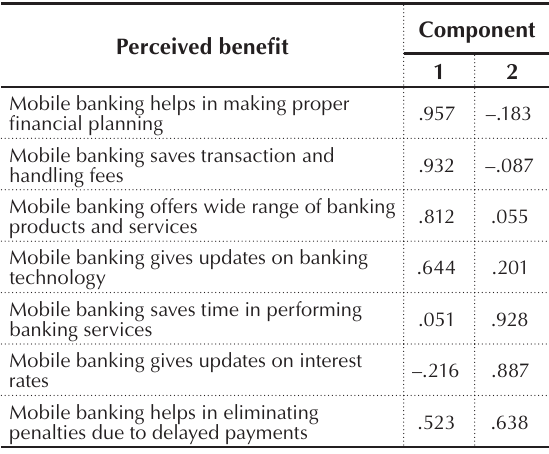
Table 4. (cid:38)(cid:258)(cid:272)(cid:410)(cid:381)(cid:396)(cid:3)(cid:258)(cid:374)(cid:258)(cid:367)(cid:455)(cid:400)(cid:349)(cid:400)(cid:3)(cid:381)(cid:374)(cid:3)(cid:393)(cid:286)(cid:396)(cid:272)(cid:286)(cid:349)(cid:448)(cid:286)(cid:282)(cid:3)(cid:271)(cid:286)(cid:374)(cid:286)(cid:302)(cid:410)